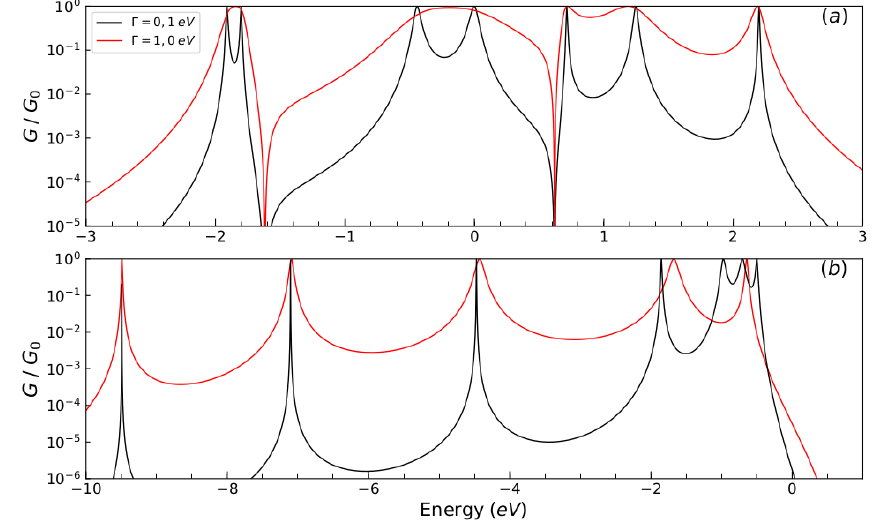
Figure 4. (color online) Normalized conductance ( G / G 0 ) as function of the injection energy of the electron E , for the molecular system with one thiophene ring for different values of Γ : ( a ) E c = E s = 0 eV, t τ = t d = t c = t δ = t s = 1.0 eV, (Black line) Γ = 0.1 eV and (red line) Γ = 1.0 eV and ( b ) E c = − 5.54 eV, E s = 0.98 eV, t d = t c = t δ = − 2.40 eV, t τ = t s = − 0.83 eV, (Black line) Γ = 0.1 eV and (red line) Γ = 5.32